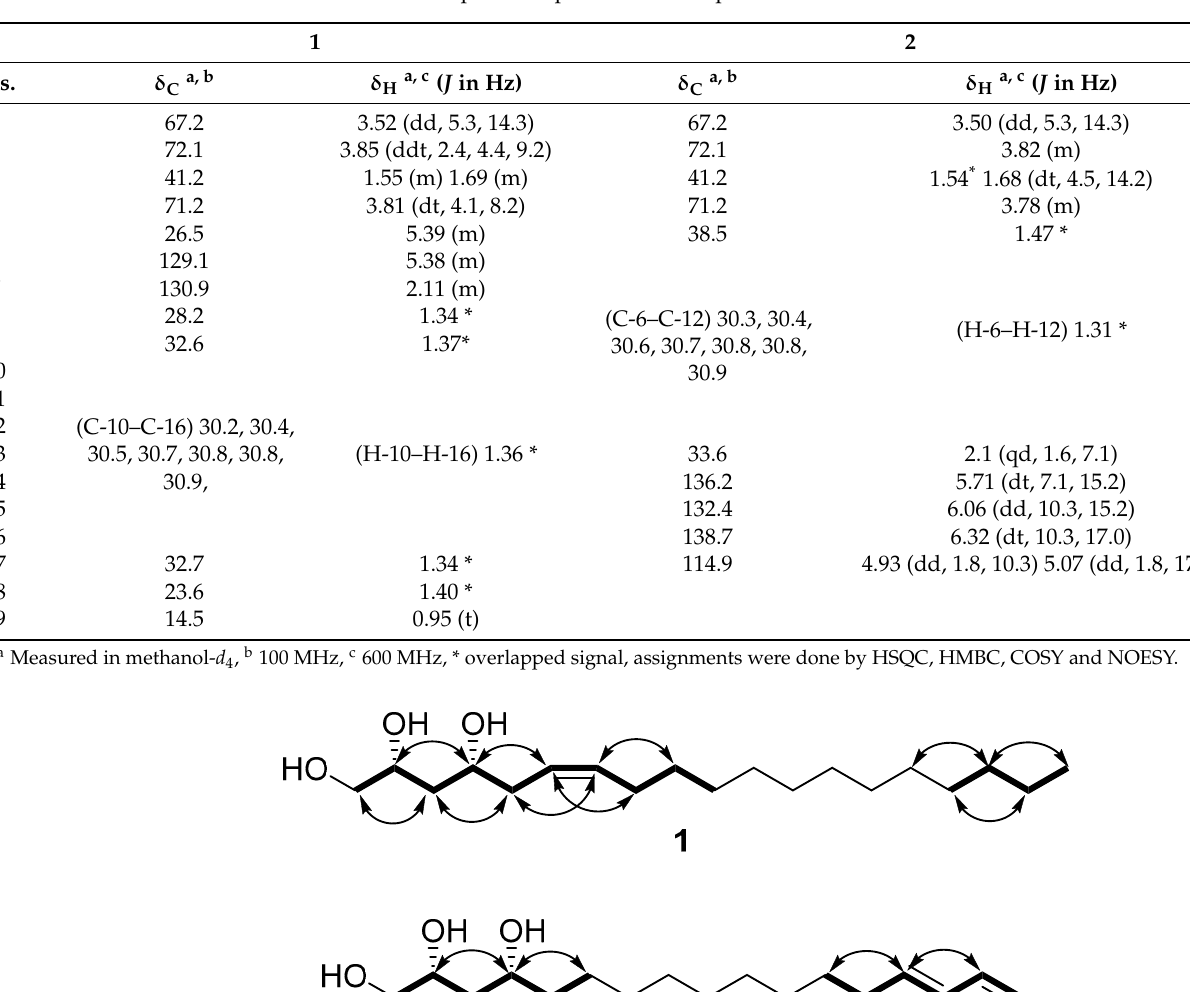
Table 1. NMR spectroscopic data for compounds 1 and 2 .